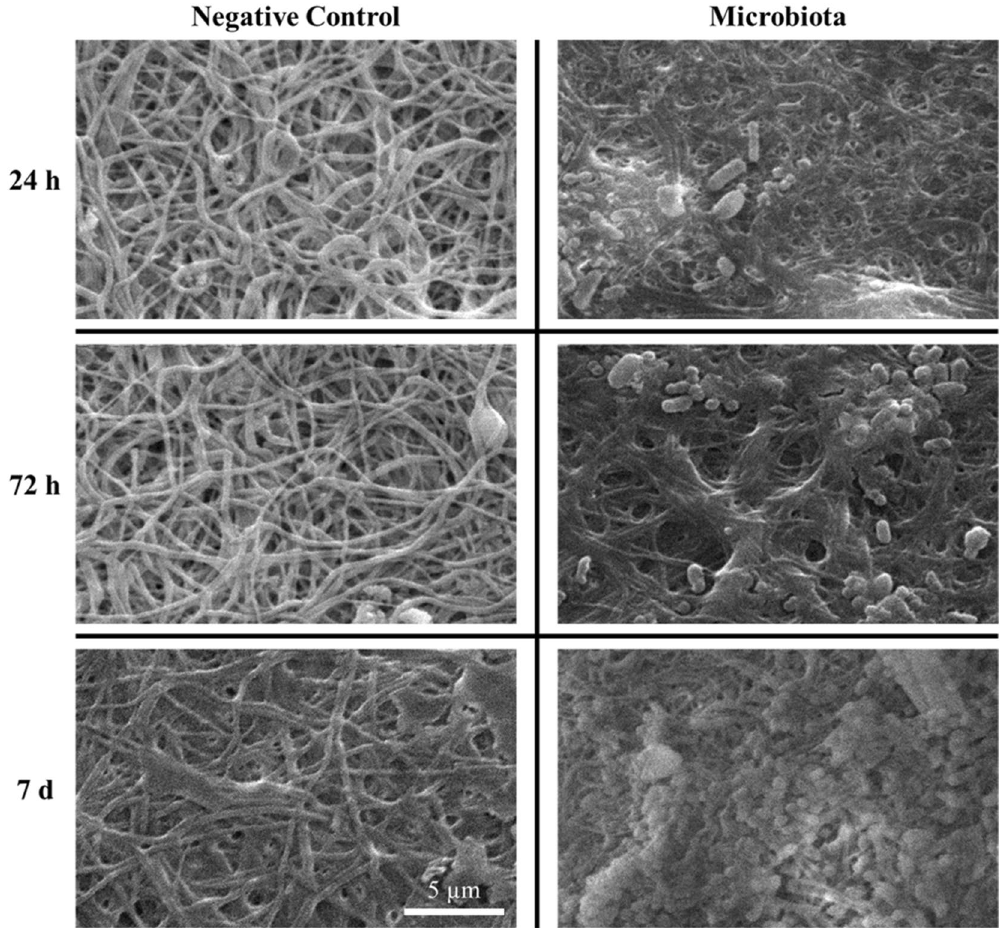
Figure 3. Electron microscopy of electrospun scaffolds without microbes (negative controls) and with the fecal microbiota (× 4000 magnification) at 24 h, 72 h, and 7 days